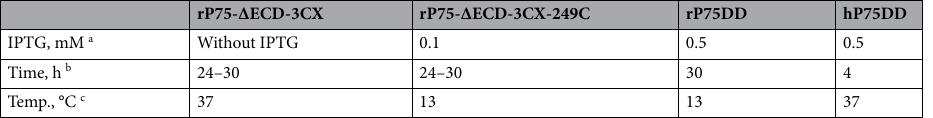
Table 2. The cultivation conditions of E. coli for expression of rP75-ΔECD-3CX, rP75-ΔECD-3CX-249C, rP75DD and hP75DD proteins. a Final concentration of inductor, IPTG. b The time of cells growth after induction. c The temperature of cells cultivation after